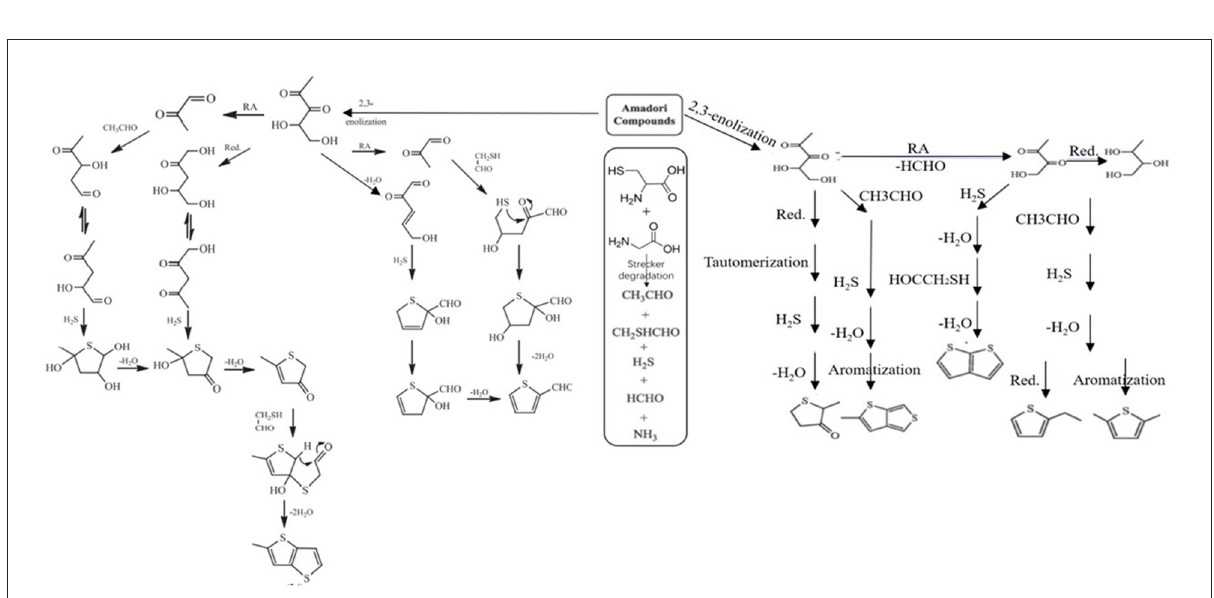
FIGURE2 Possible formation pathways for compounds in the Gly-Cys reaction systems (Red., reduction reaction; RA, retro-aldol reaction)